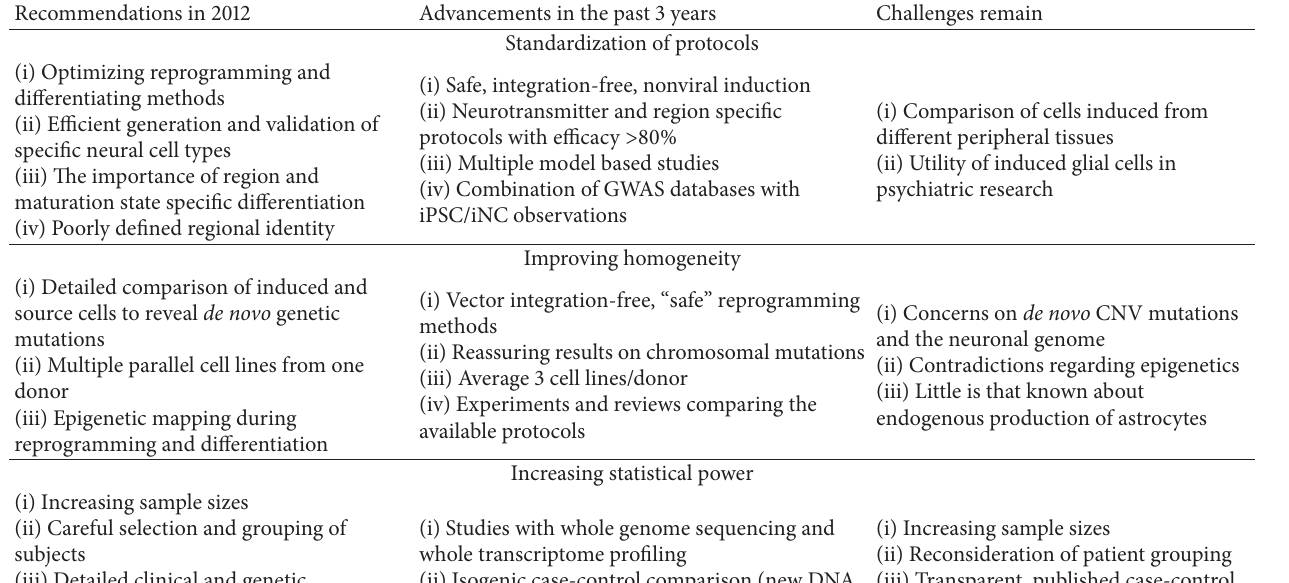
Table 1: Advancements and further challenges of the utility of induced pluripotent/neural cells in psychiatric research. The recommendations were conceived on a meeting of the National Institute of Mental Health and the Foundation for NIH in 2012